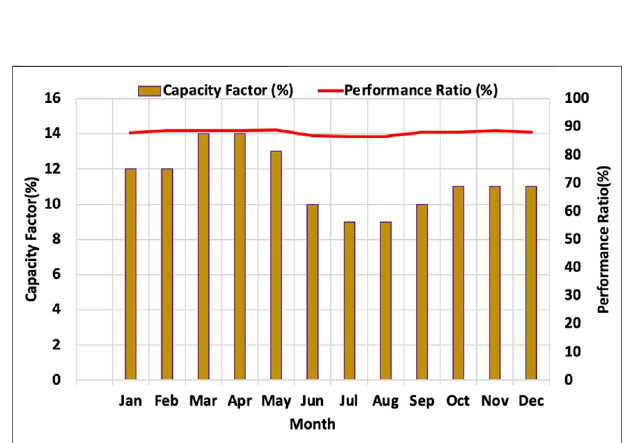
FIGURE 2 | (A) Estimated energy generated and ef fi ciency of the PV plant (B) Monthly speci fi c energy output of the plant (C) Average monthly and hourly energy injected into grid by the PV plant.